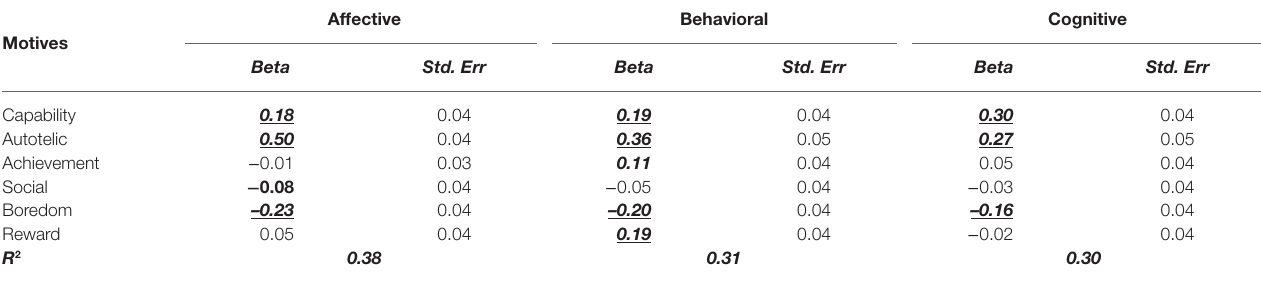
TABLE 5 | Multiple regressions between autonomous motives to participate in a learning experience and experienced level of engagement.